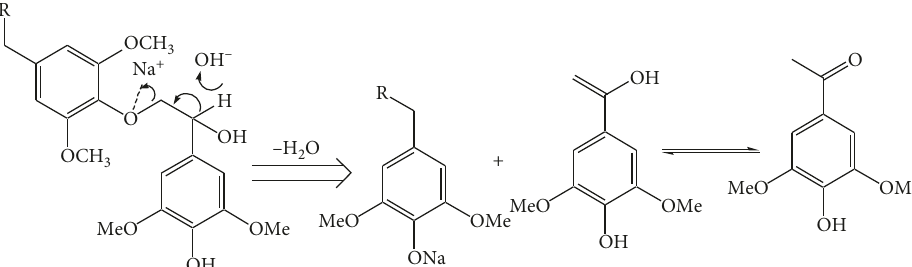
Scheme 9: Cleavage of the β -O-4 bond and formation of synringyl derivatives.